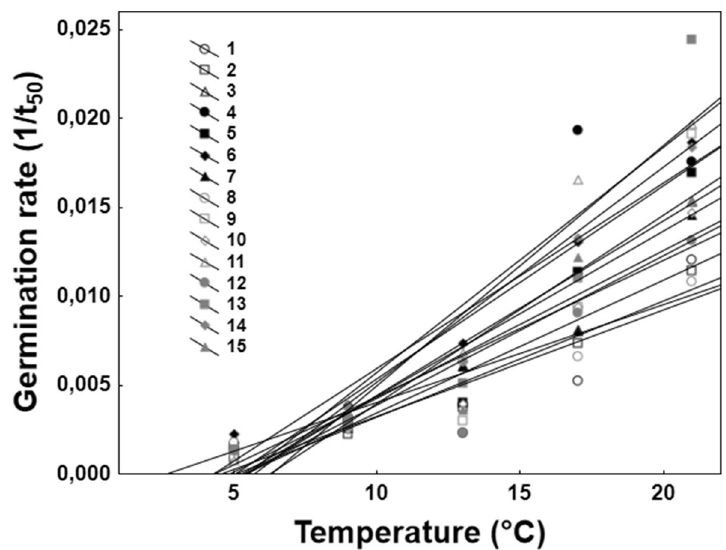
Fig. 4 Effect of germination temperature on seed germination rate (1/ t 50 ) in the 15 Tunisian Quercus ilex populations studied and determination of seed base temperature, Tb (ordinate) for seed germination